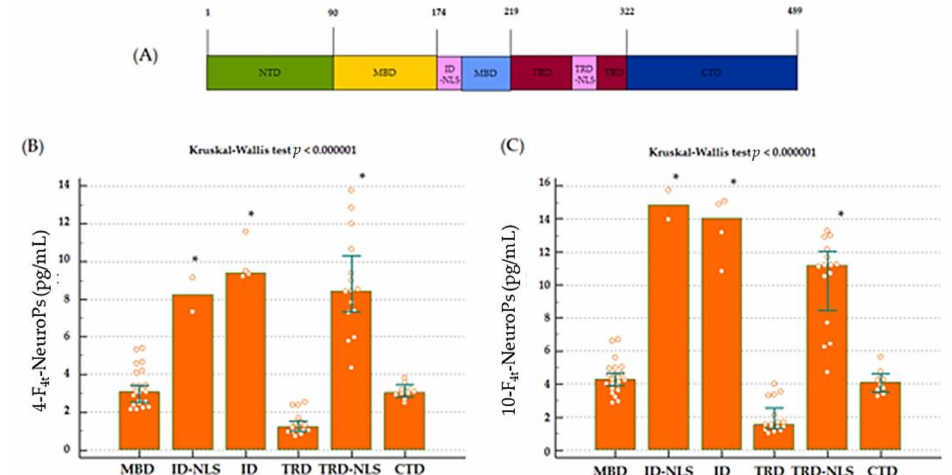
Figure 4. Plasma levels of 4-F 4t -NeuroP and 10-F 4t -NeuroP in RTT subjects with different affected MeCP2 protein domain. In panel ( A ) schematic representation of MeCP2 protein structure, amino acid number is reported. In panel ( B , C ) plasma levels of 4-F 4t -NeuroP and 10-F 4t -NeuroP in RTT patients with affected MeCP2 protein in different protein domain. None of the mutations in the investigated RTT subjects was located at the NTD protein domain Legend: NTD: N-terminal domain; MBD: methyl binding domain; ID: Inter domain; ID-NLS: Inter domain—nuclear localization signal; TRD: Transcriptional repression domain; TRD-NLS: Transcriptional repression domain—nuclear localization signal; CTD: C-terminal domain. Data are expressed as medians and interquartile ranges. * Different from CTD, MBD, and TRD, post hoc analysis (Conover), p < 0.05.